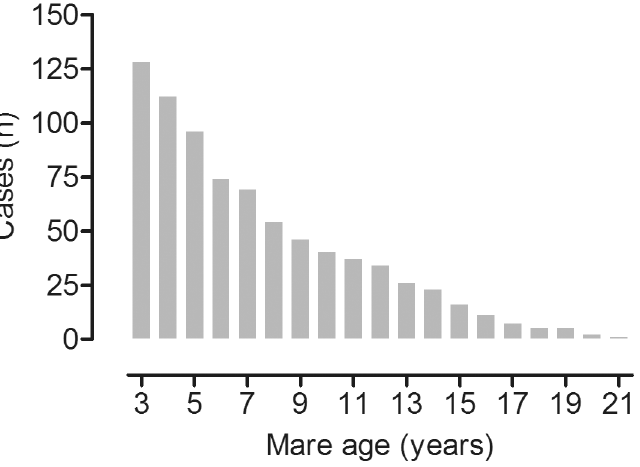
Fig 1. Mare age at breeding. Distribution of cases included into the analysis (n = 786) in relation to the age of the respective mare at breeding — mares (n = 142) were bred for the first time at the age of 3y and remained within the herd for up to 19